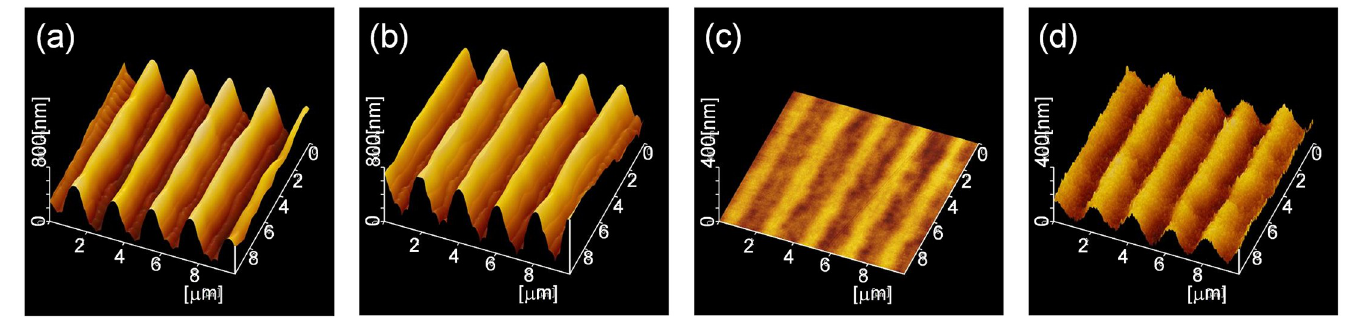
Fig 2. Surface profile of experimental sample. Azobenzene polymer (a) after holographic recording and (b) after corona discharge. Glass substrate (c) after removal of polymer and (d) after corona discharge deposition.